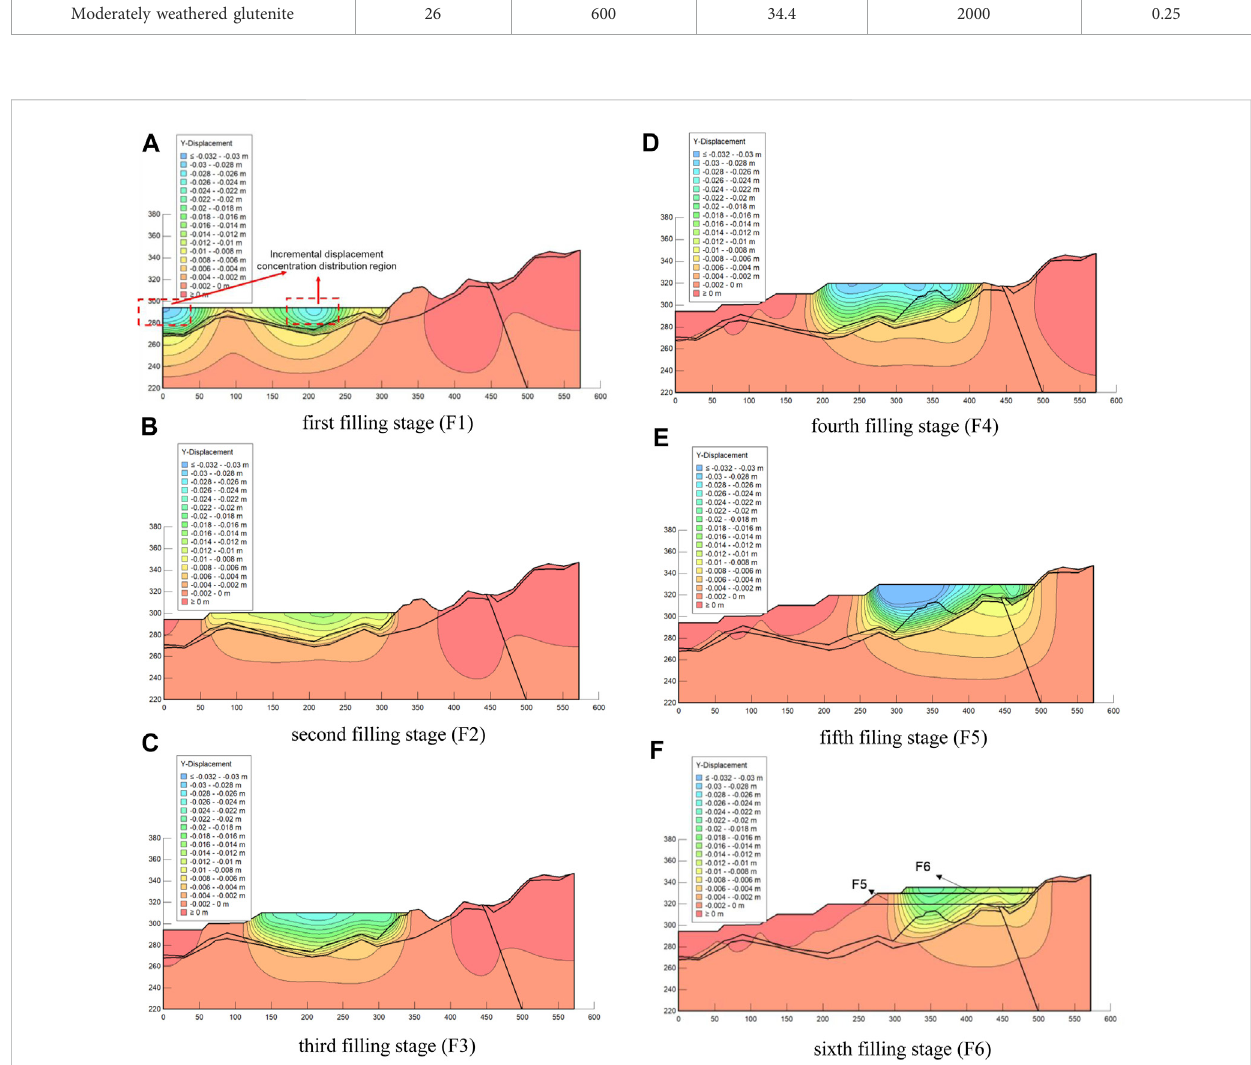
FIGURE 7 Incremental displacementdistribution contourofthehigh- fi lleddepositslope inthey-directionduringtheFarea fi llingprocess: (A) fi rst fi llingstage (F1); (B) second fi lling stage (F2); (C) third fi lling stage (F3); (D) fourth fi lling stage (F4); (E) fi fth fi ling stage (F5); (F) sixth fi lling stage